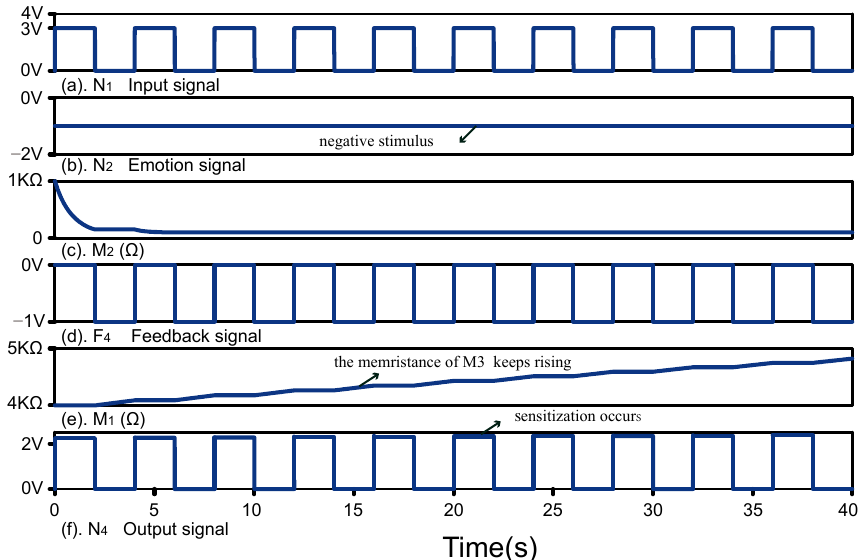
Figure 15. Sensitisation. ( a ) Input signal. ( b ) Emotion signal. ( c ) Memristance of M 2 . ( d ) Feedback